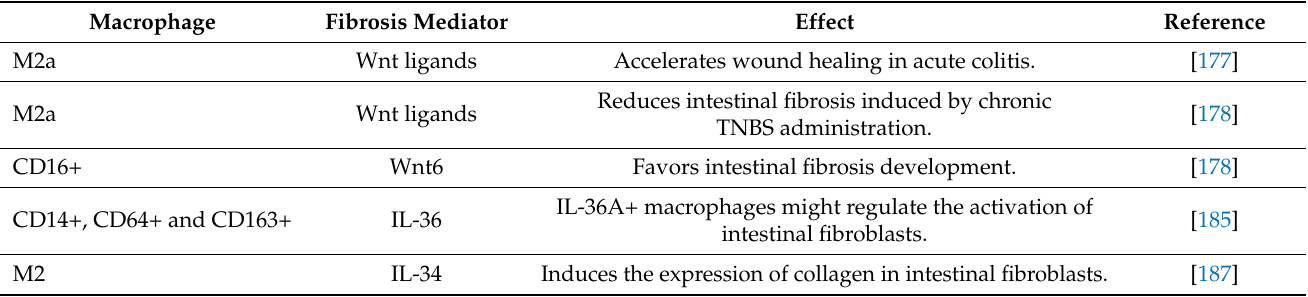
Table 5. Table summarizing how and which types of macrophages are involved in intestinal fibrosis.